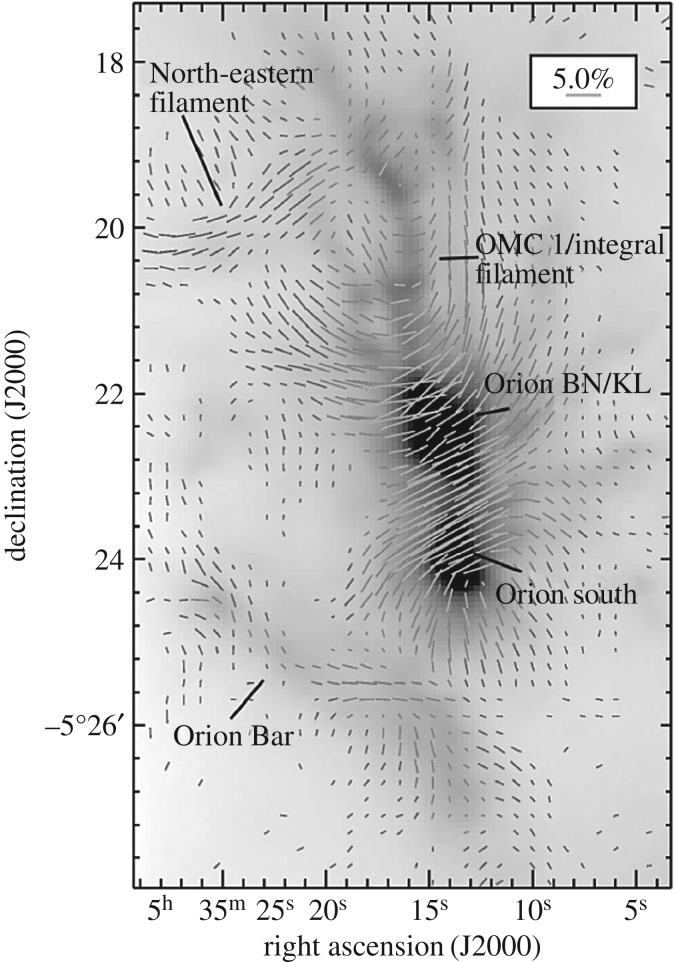
850 μm Polarization map of the central region of the Orion molecular cloud, in which the measured polarization vectors are rotated by 90° to show the B-field direction. Adapted from Ward-Thompson et al. [144].